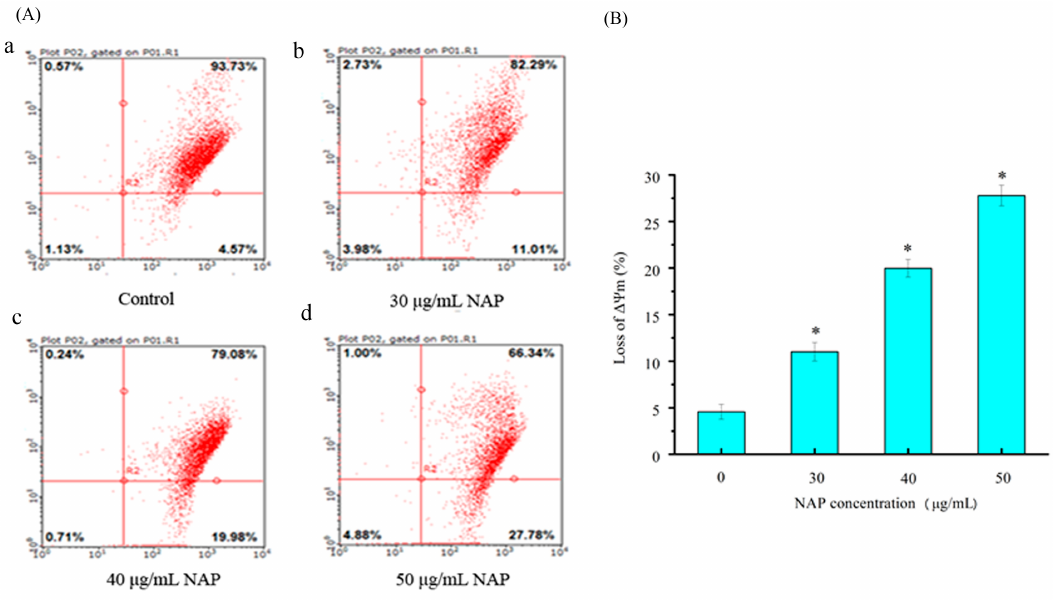
Figure 5. The effect of NAP on ΔΨ m on H1299 cells. ( A ) Flow cytometry analysis of H1299 cells by the ΔΨ m method. The percentage of ΔΨ m change was 4.57% (a) in the negative control cells; 11.01% (b) in the 30 μ g/mL NAP-treated cells; 19.98% (c) in the 40 μ g/mL NAP-treated cells; and 27.78% (d) 50 µ g/mL NAP-treated cells; ( B ) The percentage of loss of ∆Ψ m. All data are presented as the mean in the 50 μ g/mL NAP-treated cells; ( B ) The percentage of loss of ΔΨ m. All data are presented as the mean ± standard deviation (SD) of three experiments. * p < 0.05 vs. control.